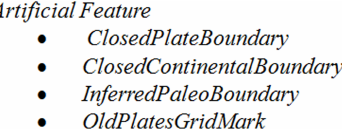
Fig. 5. Four artificial features defined in GPGIM.